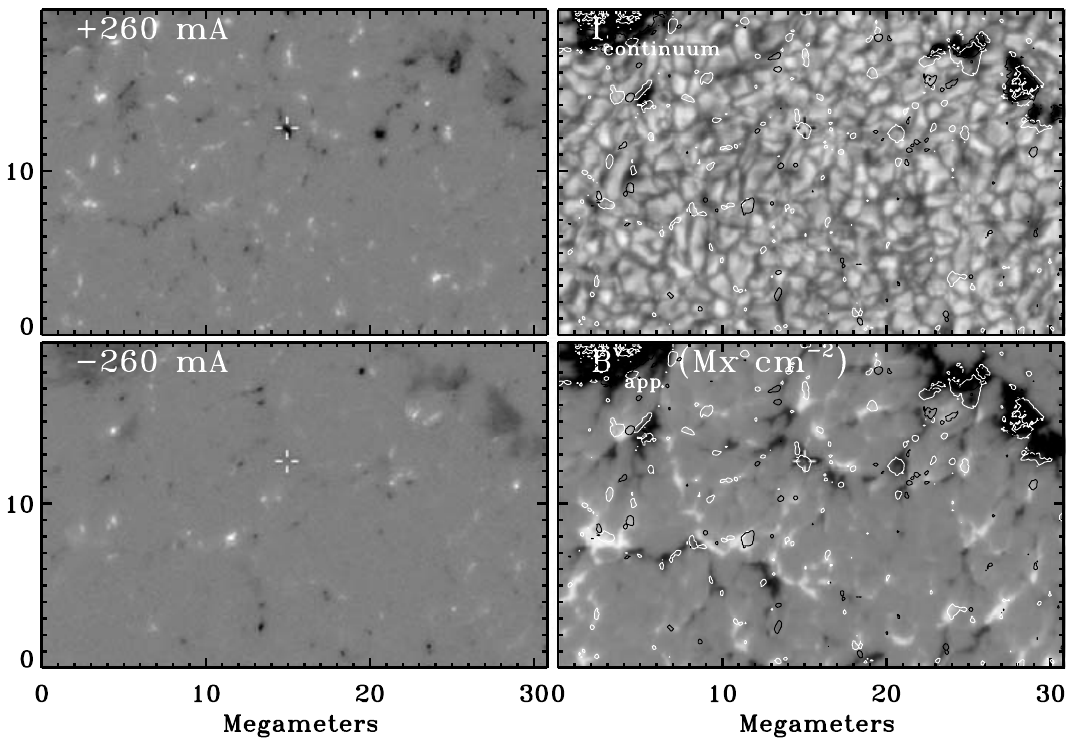
Figure 31: Hinode Spectropolarimeter (SP) observations of an emerging flux in NOAA AR 10978. The upper and lower right panels show the continuum intensity and line-of-sight magnetic flux densities, re- spectively. The left panels show the Stokes V signal at ± 260 m˚A from the center of the Fe i 6302.5 ˚A line. The mixed polarity pattern in the simulated magnetograms of Figure 27 shows some resemblance the observed pattern. Image reproduced with permission from Lites (2009), copyright by